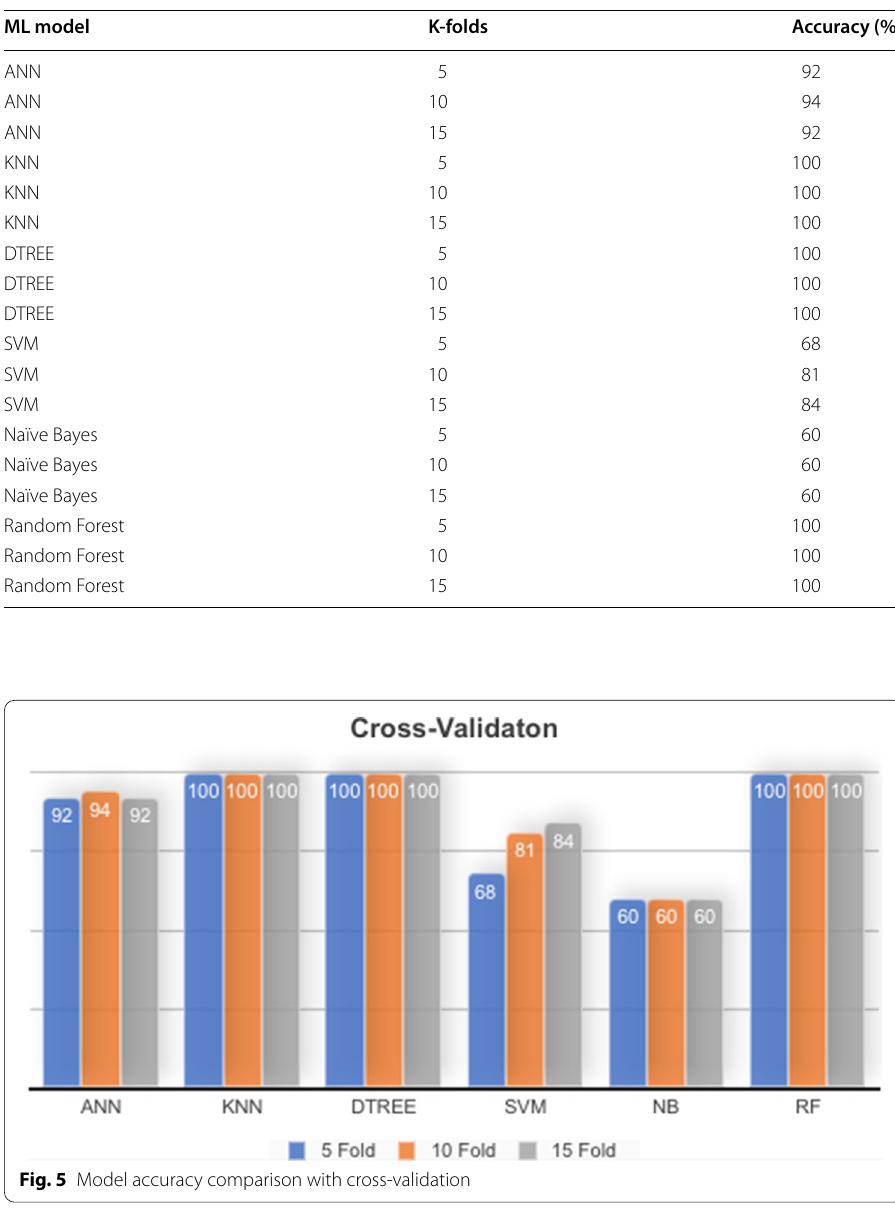
Table 22 Cross-validation result for ML models